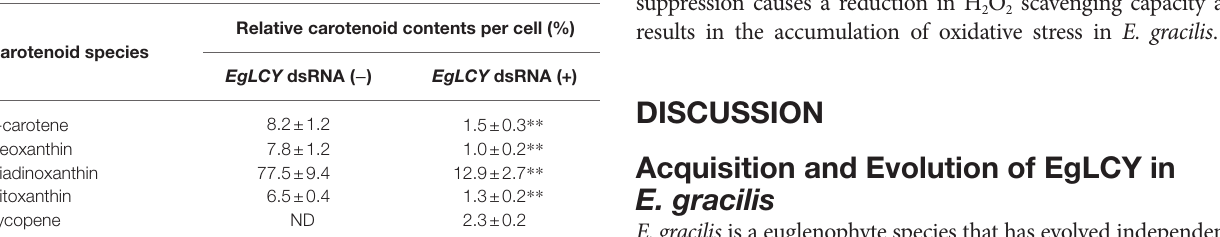
TABLE 1 | Effects of EgLCY suppression on carotenoid compositions.